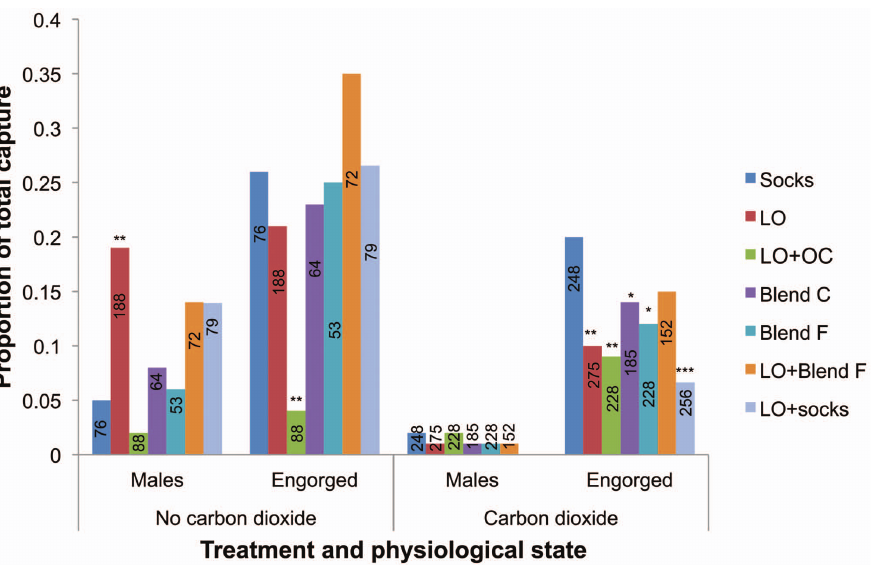
Figure 2. Proportions of male and engorged female An.gambiaes.l. caught by different odor treatments. The bars show the proportions of male and engorged (blood-fed + semi-gravid/gravid) female An. gambiae s.l. ; numbers embedded in the bars are the total of mosquitoes caught by each of the odor treatment; LO = ( E )-linalool oxide; OC = b -ocimene; the different treatments were compared to socks (control); bars capped with asterisks are significantly different from their respective controls as determined by chi square test of proportions in R 2.15.1 software * = P , 0.05, ** = P , 0.01, *** = P , 0.001.